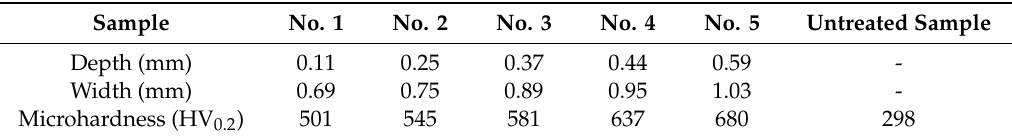
Figure 8. Optical microscopy images of the cross-sectional morphology of units: ( a ) No. 1, ( b ) No. 2, ( c ) No. 3, ( d ) No. 4, and ( e ) No. 5. ( c ) No. 3, ( d ) No. 4, and ( e ) No. 5. Table 3. The dimensions and microhardness of the